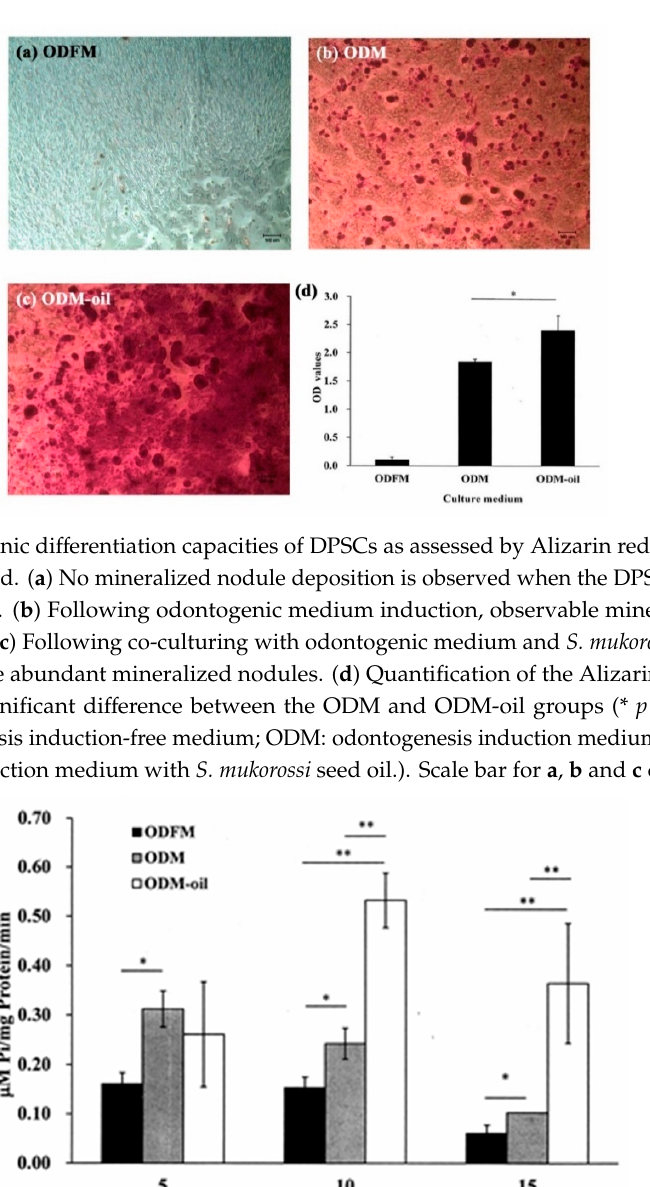
Figure 6. Alkaline phosphatase activity assessment of three experimental groups following culture periods of 5, 10 and 15 days. After culture periods of 10 and 15 days, the ODM-oil group reveals a significantly higher ALP activity expression than ODFM group and ODM group. * p < 0.05, ** p < 0.01. (Note ODFM: odontogenesis induction-free medium; ODM: odontogenesis induction medium; and ODM-oil: odontogenesis induction medium with S. mukorossi seed